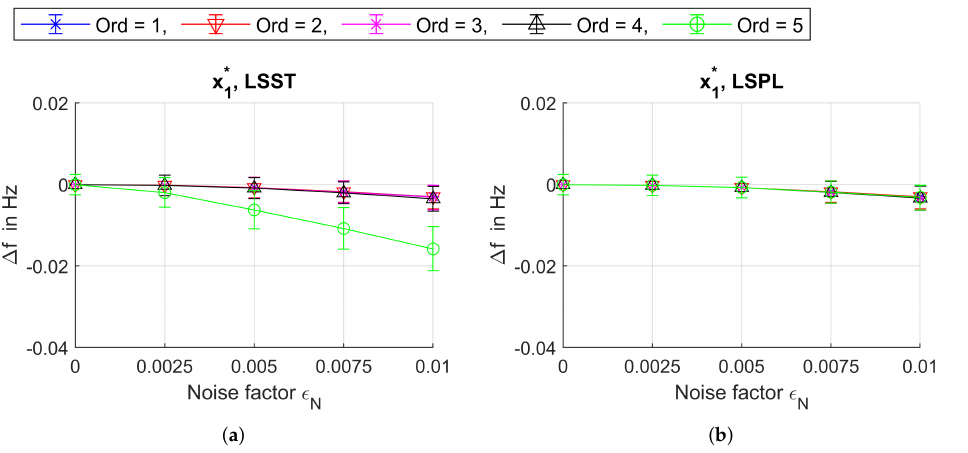
( 0 ) and the two methods 1